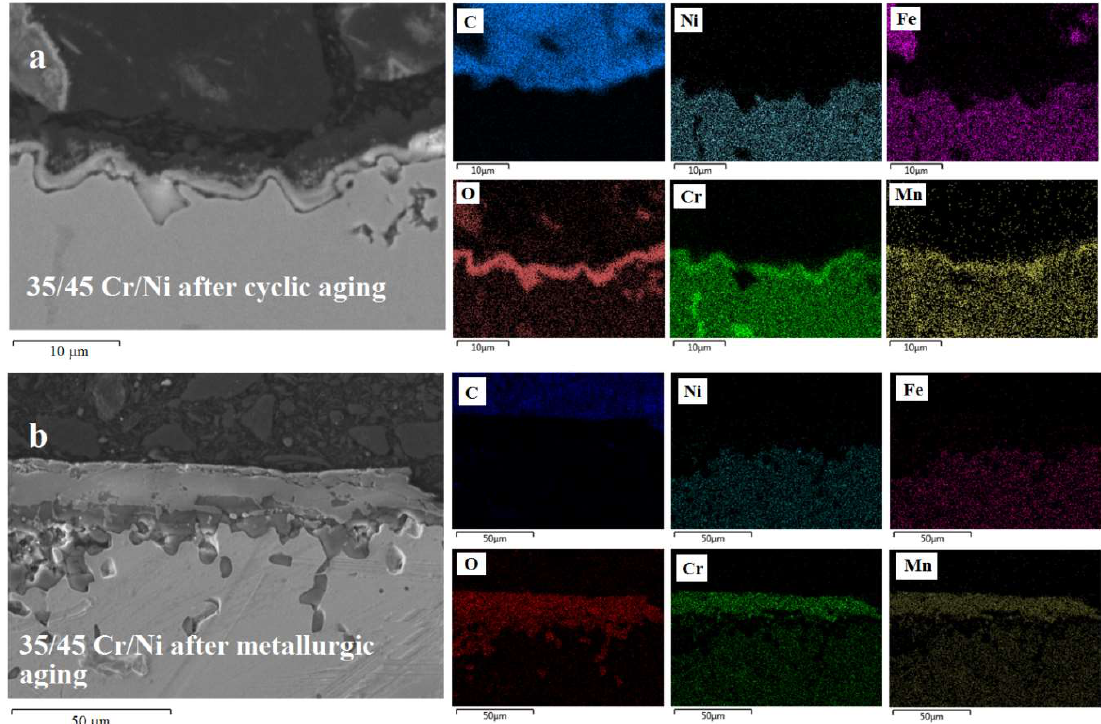
Figure 10. SEM-EDX images of a 35/45 Cr/Ni alloy after cyclic aging ( a ) and after metallurgic aging ( b ). Magnification: 3000× ( top ) and 1000× ( bottom ), Accelerating Voltage: 15 kV.